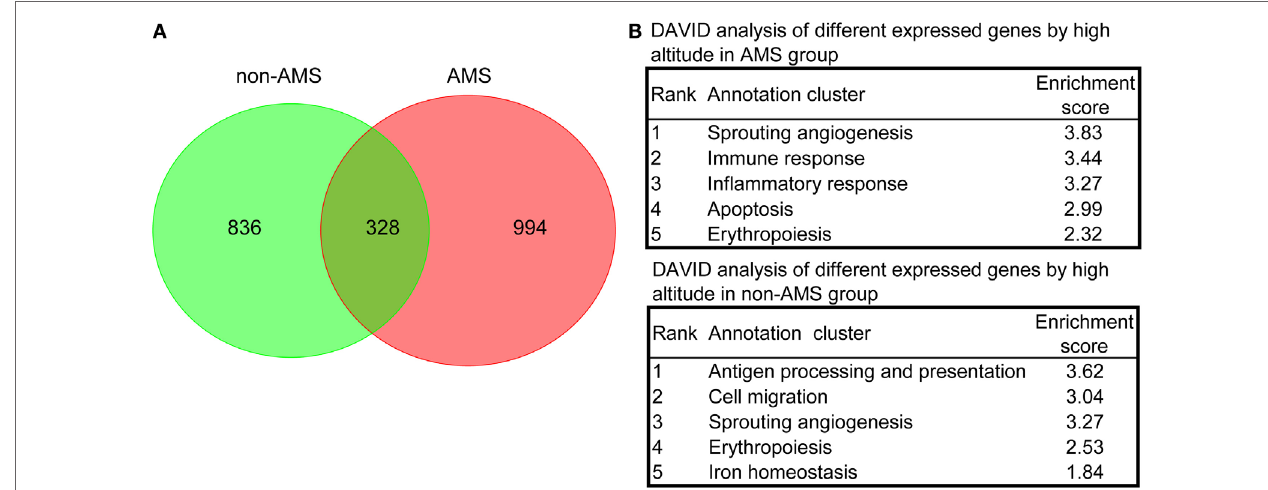
FigUre 2 | Differentially expressed transcripts and overrepresented biological processes in non-acute mountain sickness (aMs) and aMs groups . (a) Venn diagram showing the number of transcripts equally and differentially expressed in whole blood cells derived from non-AMS and AMS individuals. (B) The top five representative biological modules of differentially expressed transcripts for non-AMS and AMS groups.